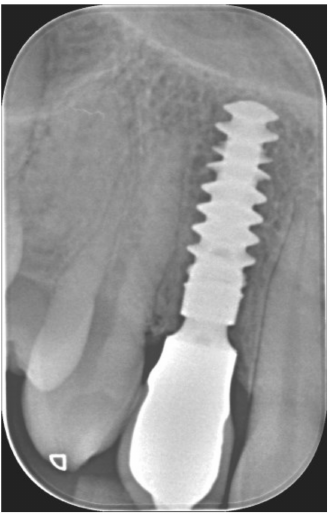
Figure 10. Periapical X-ray at 1 year of